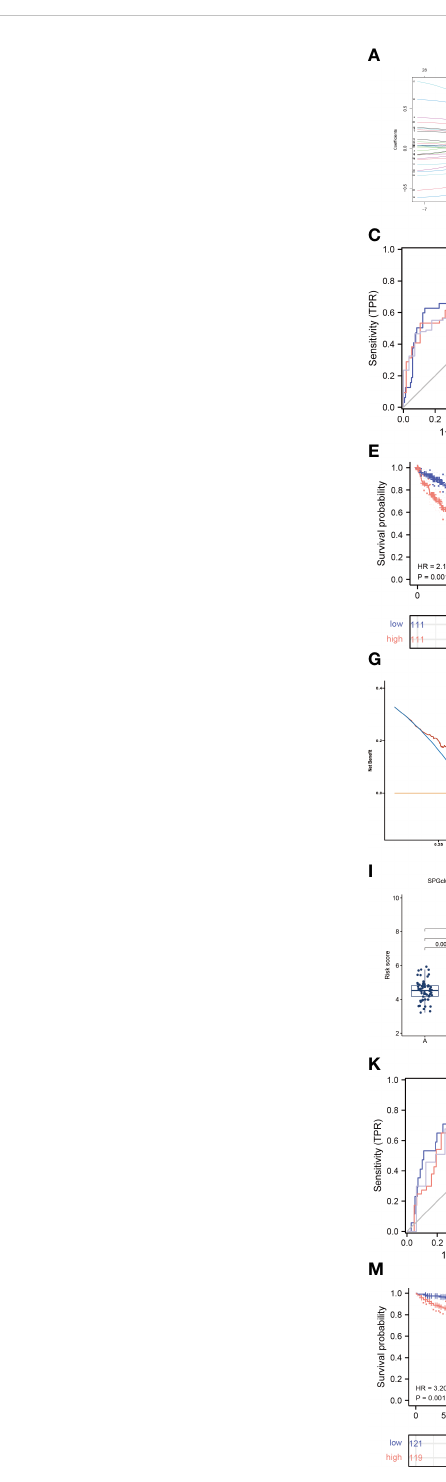
FIGURE 4 Identify sphingolipid-associated predictive signature. (A, B) LASSO analysis identi fi ed 6 prognostic SPGs. (C, D) The time-dependent ROC exhibited the sensitivity and speci fi city of constructed riskscore model. (E, F) Survival probability of differential risk subgroups. (G, H) Decision curve analysis of 6-SPGs riskscore model for predicting survival status, including OS and PFS. (I) Risk score in 4 SPGclusters. (J) Alluvial diagram of SPGcluster and associated living status. (K, L) Validity of the model in the external validation sets. (M, N) Survival probability of differential risk subgroups in external validation